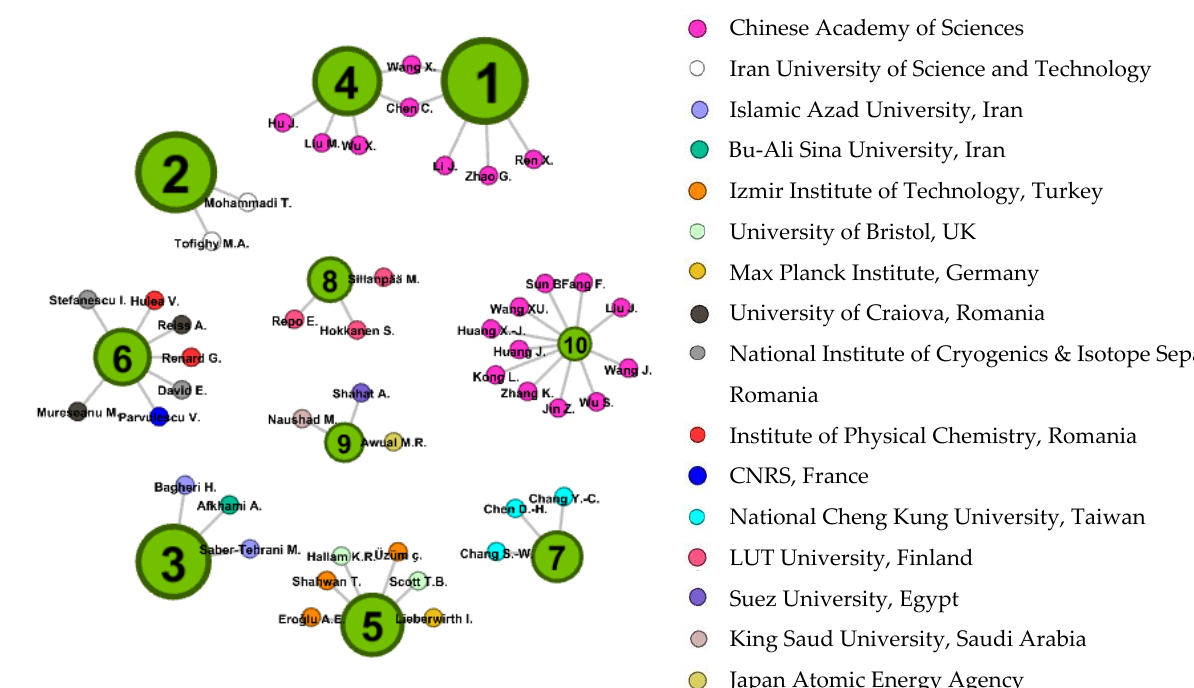
Figure 7. Authors’ network visualization and corresponding affiliations of the top 10 cited publications.